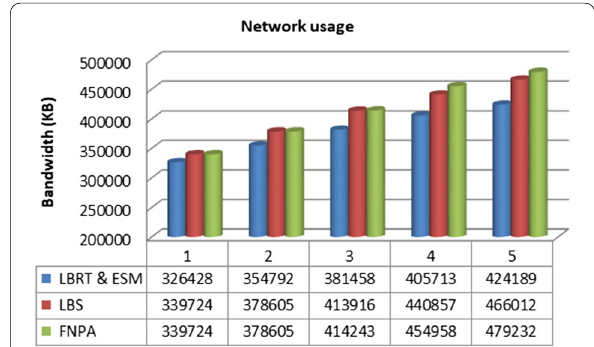
Fig. 9 Comparison of network usage